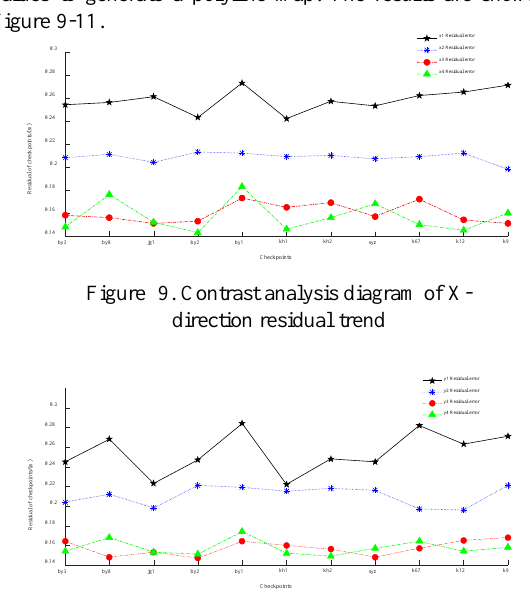
Figure 10. Contrast analysis diagram of Y- direction residual trend